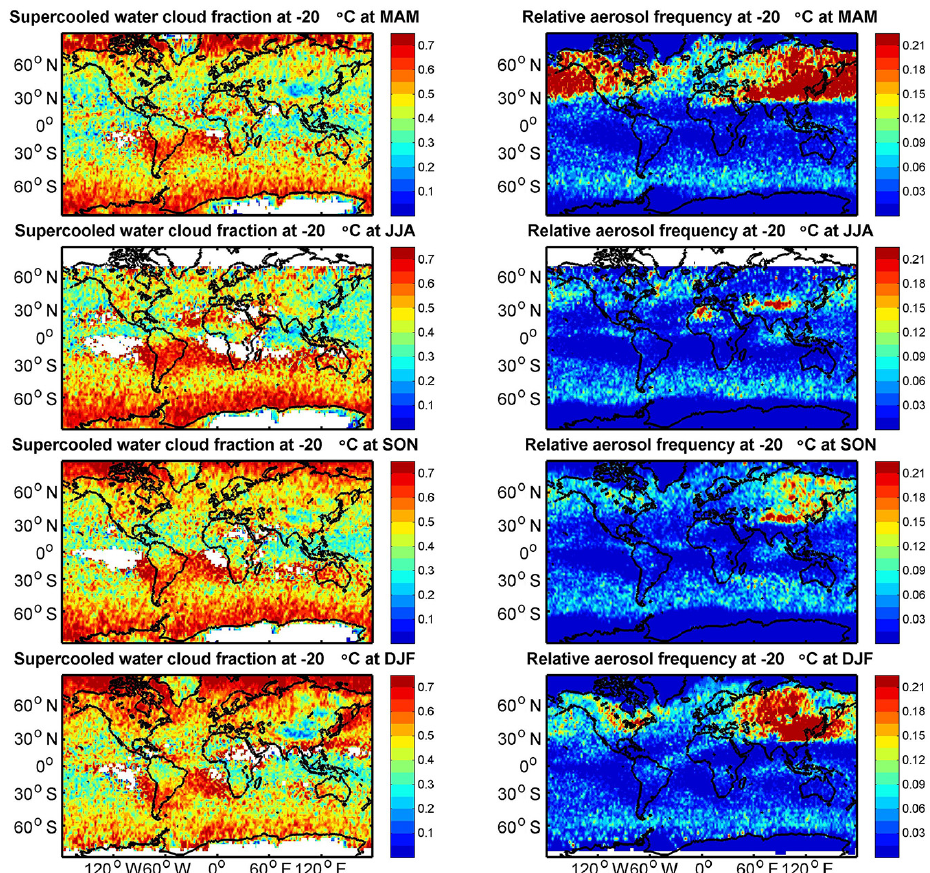
Figure 2. The global and seasonal variations of supercooled water cloud fractions (SCFs) and relative aerosol frequencies (RAFs) during nighttime at − 20 ◦ C isotherm over 2 ◦ × 2 ◦ grid